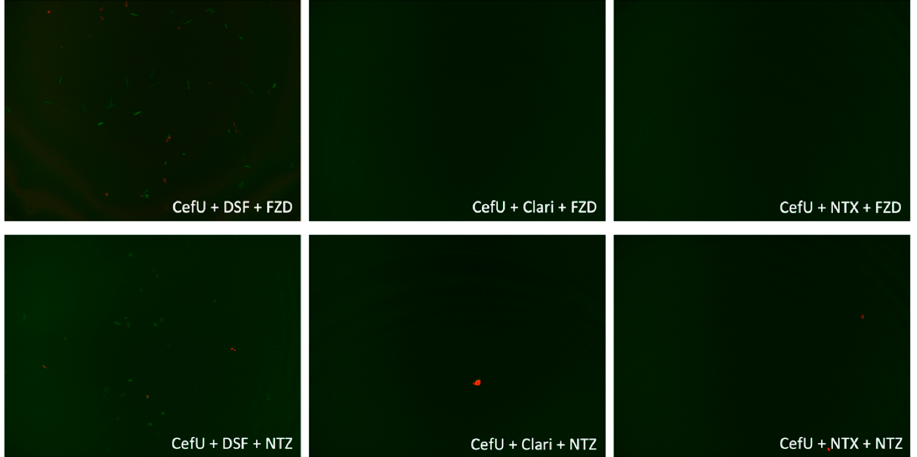
Figure 4. Subculture for comparative combinations with DSF, Clari, and NTX. Abbreviations: untreated control (Cntrl), cefuroxime (CefU), clarithromycin (Clari), disulfiram (DSF), furazolidone (FZD), nitroxoline (NTX).